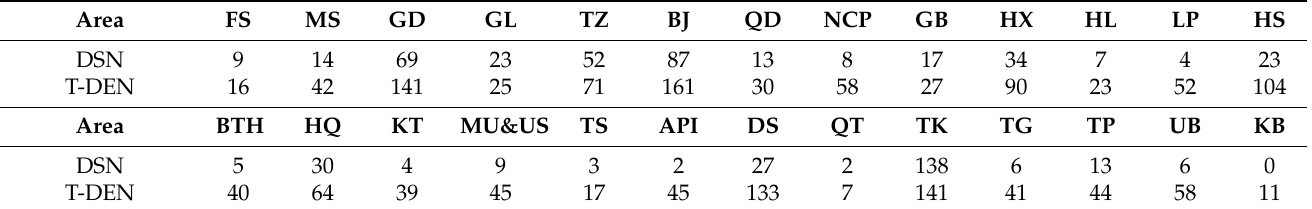
Figure 4. Spatial distribution characteristics total dust events number (T-DEN) and dust source number (DSN) from 2016 to 2020. Abbr. The sub-region names are as same as in Figure 1. Table 2. Statistical table of total dust events number (T-DEN) and dust source number (DSN) in each sub-region. Abbr. The sub-region names are as same as in Figure 1.